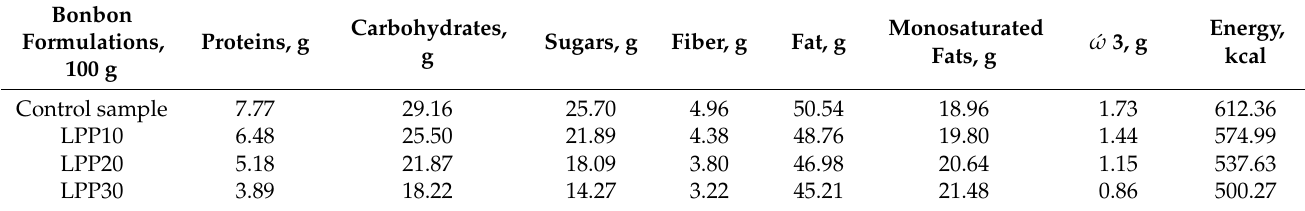
Table 2. Weight (g), size (mm), ash (%), and moisture (%) content of bonbons. Table 3. Nutritional data of bonbon formulations.